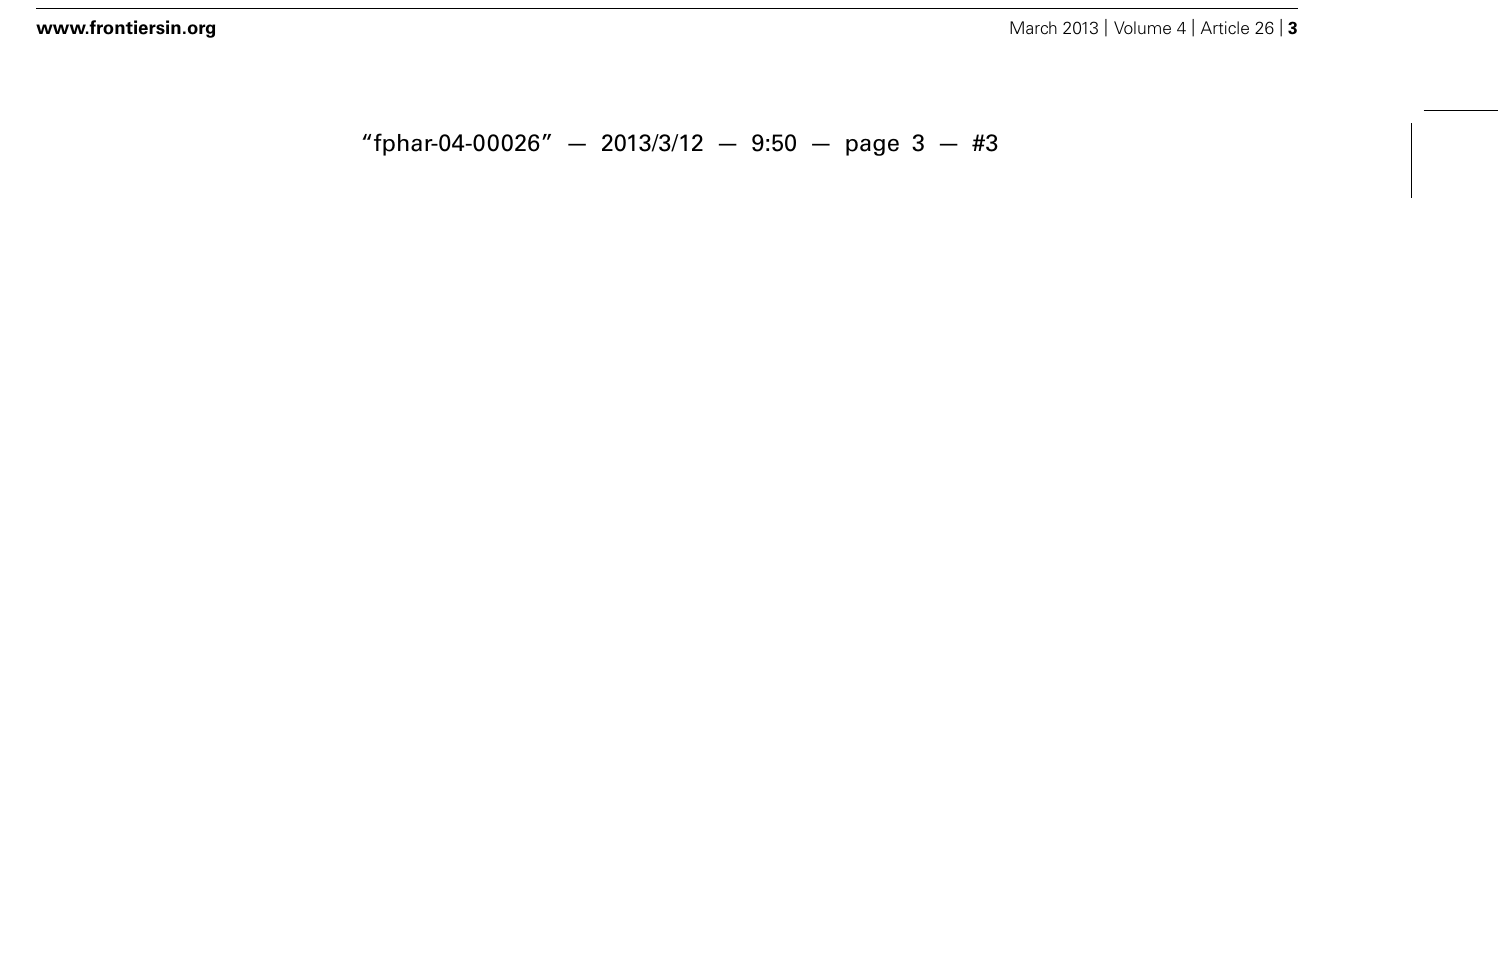
with date and time (see table) by the electronic wires in the film. Morning and evening doses are highlighted. Bedtime doses could be taken when needed. Key: ™ ◦ ◦ , morning doses; › ◦ › , evening doses; ◦ Õ , bedtime